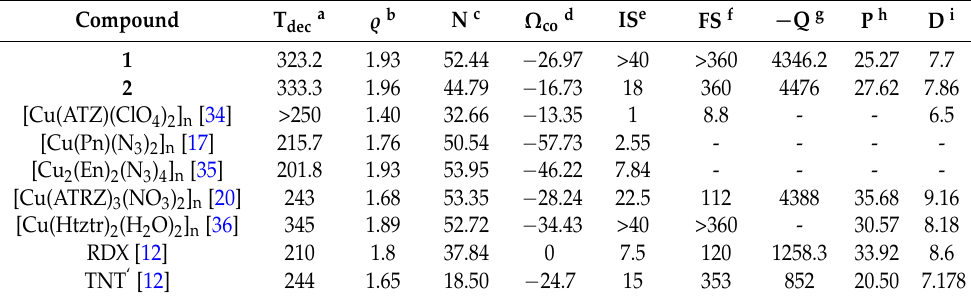
Table 1. Physiochemical properties of 1 , 2 and previously reported MOF based on copper ions. Compound T dec a